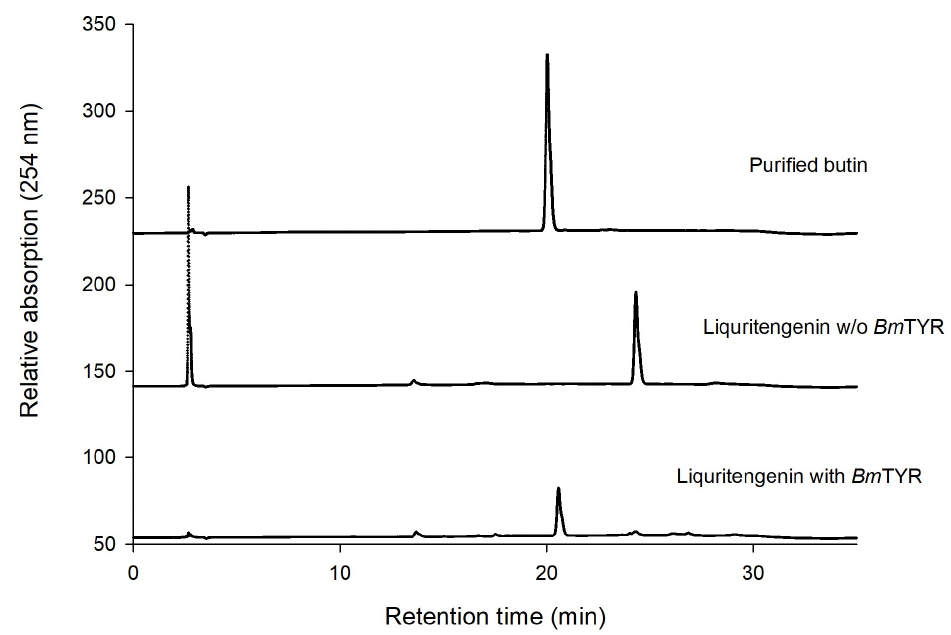
Figure 5. HPLC analysis of the biotransformation products of liquiritigenin obtained using Bm TYR. The biotransformation and HPLC conditions were the same as those in Figure 2, except that the enzyme substrate (fraction extracts) is replaced with a liquiritigenin standard.